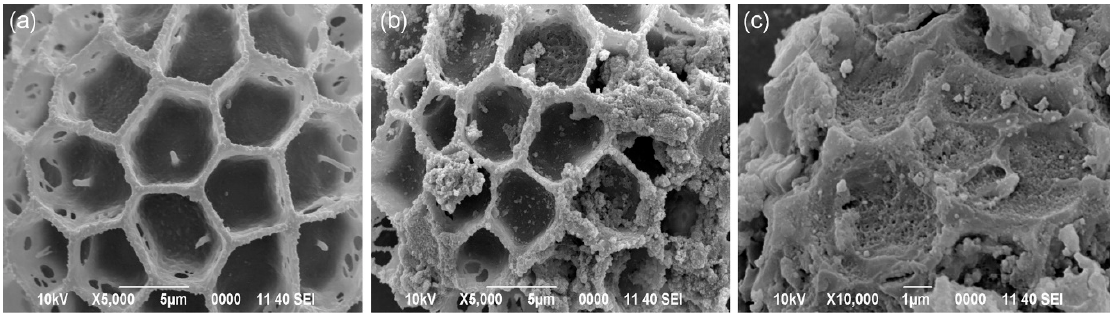
Figure 2. ( a ) Spore; ( b ) Spore covered with magnetic nanoparticles; ( c ) Final composite after the